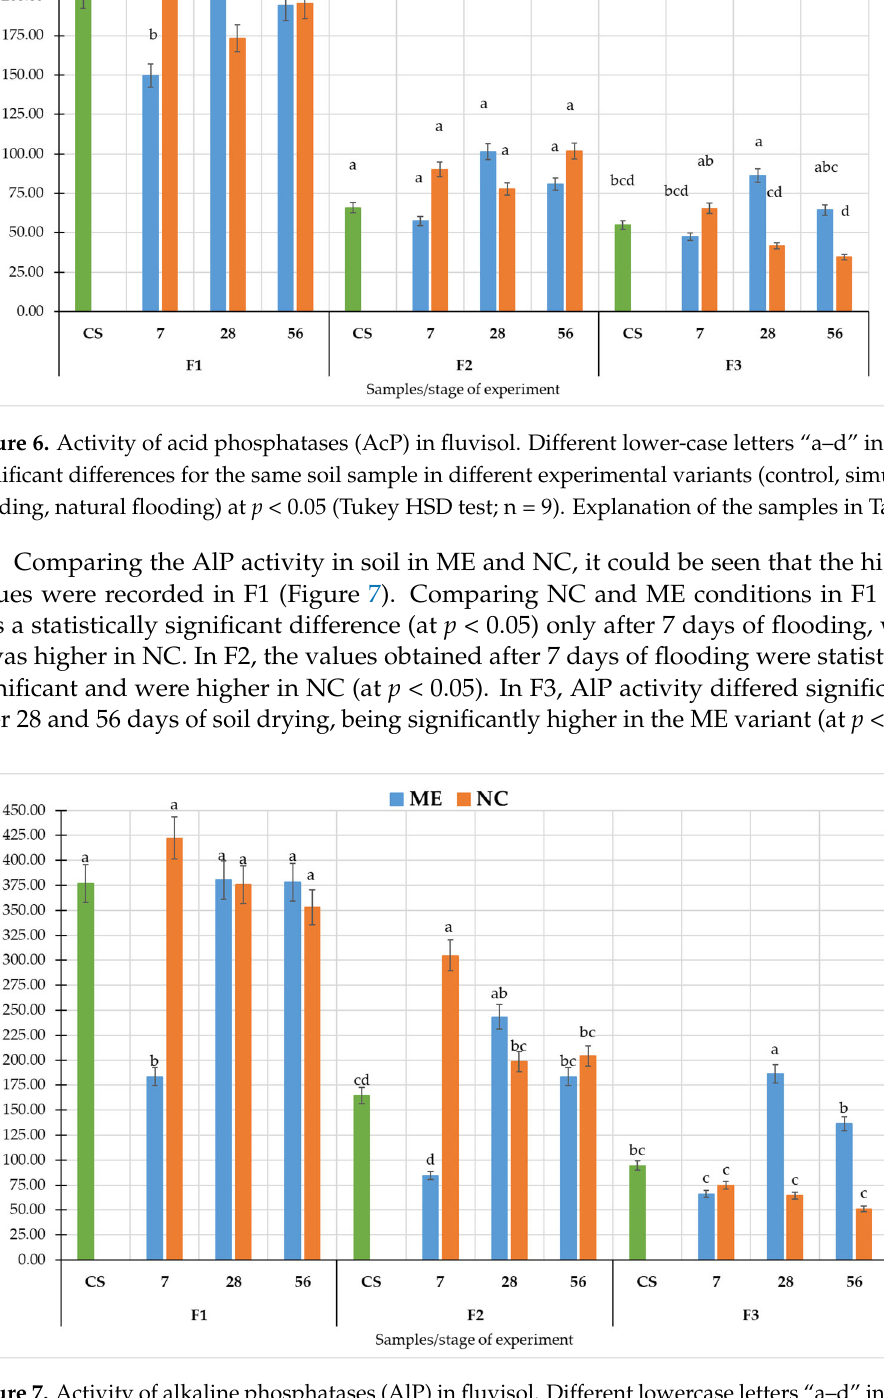
Figure 7. Activity of alkaline phosphatases (AlP) in fluvisol. Different lowercase letters “a–d” indicate significant differences for the same soil sample in different experimental variants (control, simulated flooding, natural flooding) at p < 0.05 (Tukey HSD test; n = 9). Explanation of the samples in Table